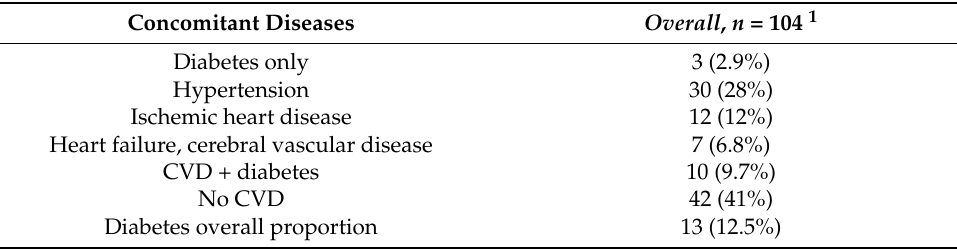
Table 2. Distribution of cardiovascular diseases and diabetes mellitus among